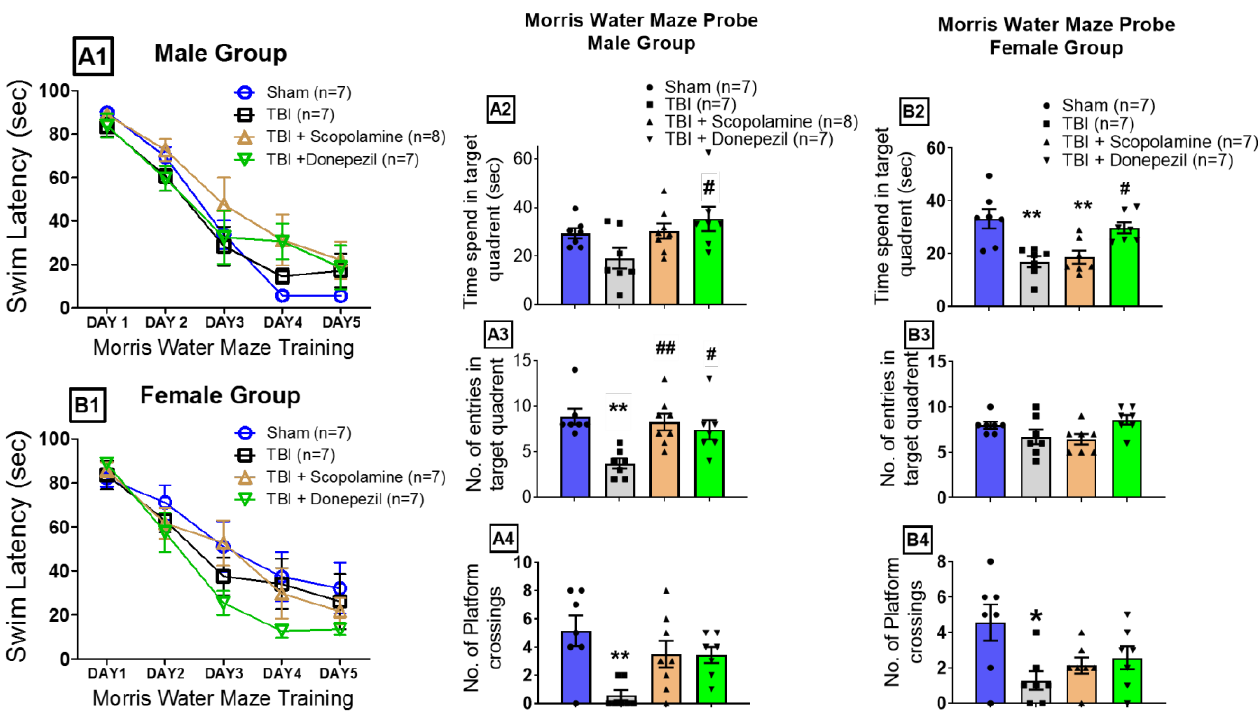
Figure 4. Effect of post-TBI muscarinic modulation on spatial memory retrieval. Graph ( A1 ) and ( B1 ) represent the Morris water maze training data for the male and female groups, respectively. ( A2 – A4 ) represent the time spent in the target quadrant, entries into the target quadrant, and platform location crossings, respectively, by the male mice during probing. ( B2 – B4 ) show the times spent in the target quadrant, the entries into the target quadrant, and the platform location crossings, respectively, by the female mice during spatial memory retrieval in the probe trial. Data are presented as mean